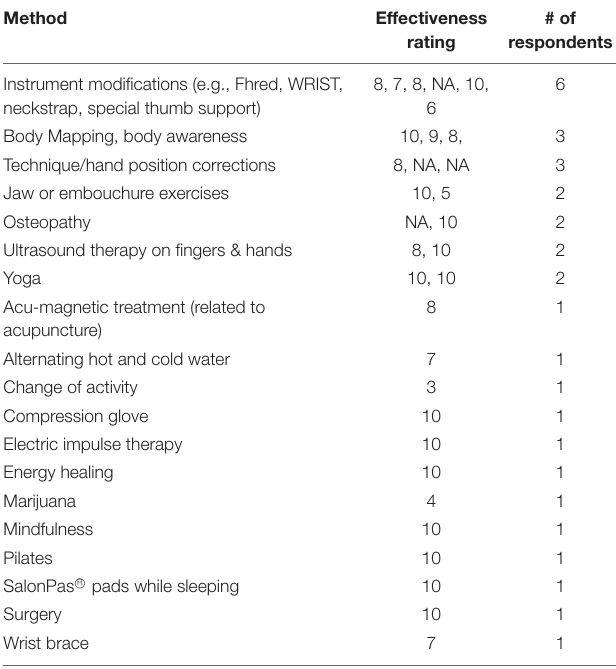
TABLE 4 | “Other” treatment methods responses and ratings. Method Effectiveness